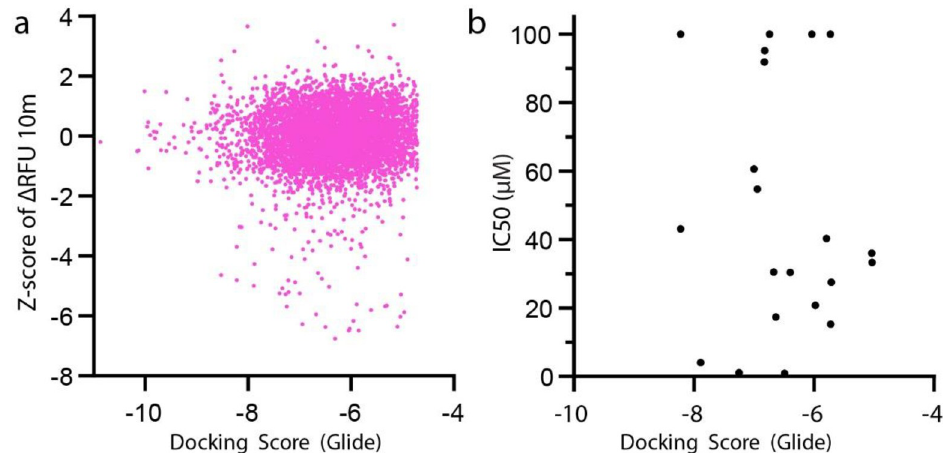
Fig 4. Correlation of experimental and in silico identification. (a) Correlation of Z-score for all Broad Repurposing library compounds and Docking Score. Pearson r = 0.02864 (95% CI 0.003478–0.05376), P value = 0.0257 and XY pairs = 6,068. Linear equation Y = 0.03452x+ 0.2202 as fitted by simple linear regression, slope significantly deviated from 0, P value = 0.0016. (b) Correlation of IC50 vs Docking Score. Pearson r = -0.1053 (95% CI -0.5136–0.3420), P value = 0.6498 and XY Pairs = 21. Linear equation Y = -4.188x+20.41 as fitted by simple linear regression, slope not significantly deviated from 0, P value =